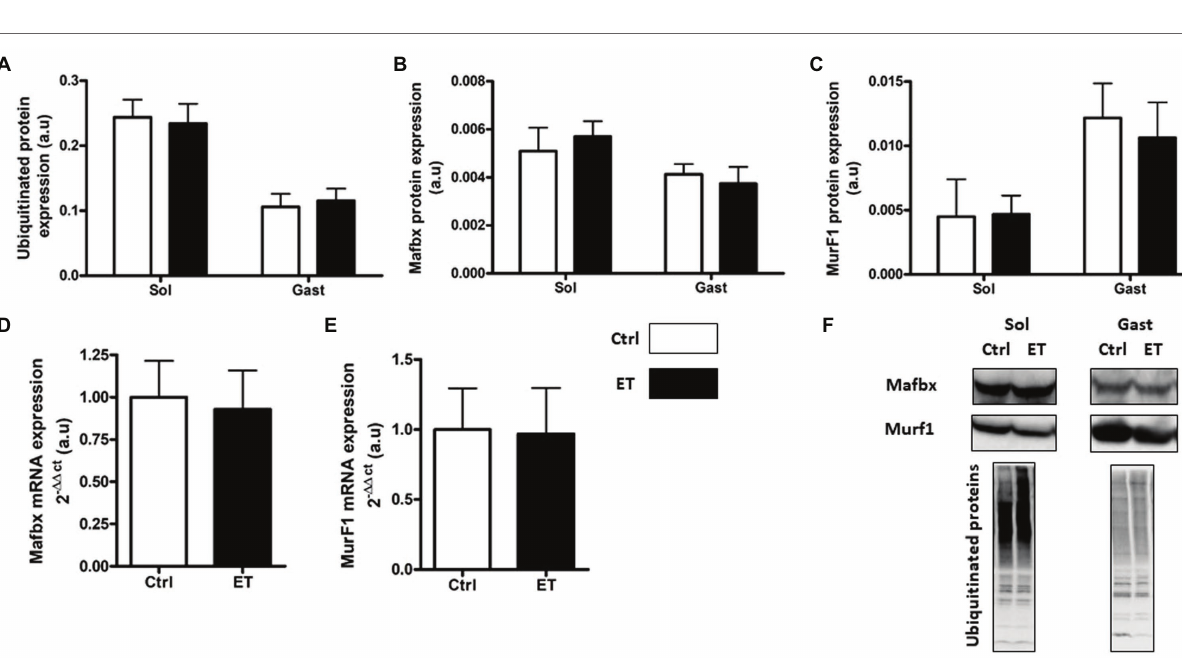
FIGURE 5 | Ergothioneine effect on ubiquitin proteasome markers (UPS) 2 h after exercise. UPS markers in soleus and gastrocnemius samples and expression of genes encoding UPS markers in gastrocnemius samples. (A) Total ubiquitinated proteins. (B) MAFbx protein expression. (C) MurF1 protein expression. (D) Mafbx mRNA expression. (E) MurF1 mRNA expression. (F) Representative Western Blots; * p < 0.05 vs.